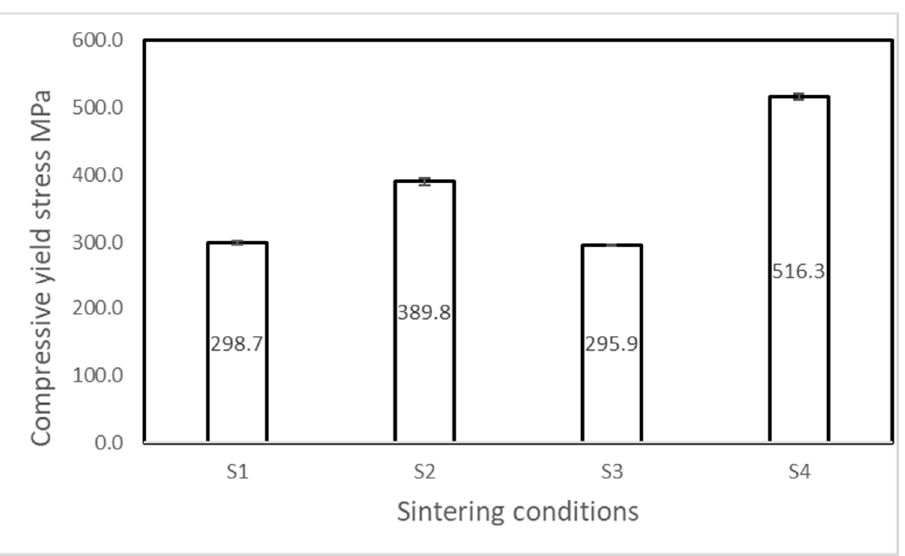
Figure 11. Compressive yield stress of the as-sintered HEA NiMnFeCu under various sintering con- ditions. Table 6. Compressive yield stress of 3d transition metal based HEAs reported in the literature.